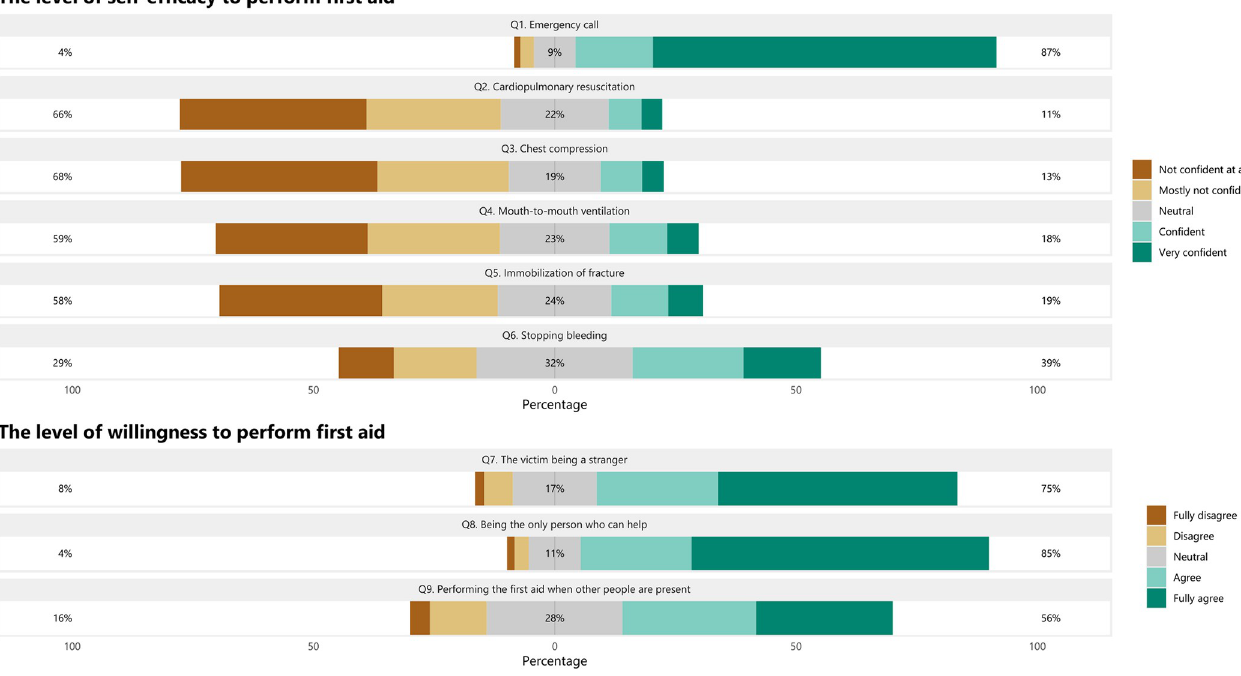
Fig 2. The self-efficacy and willingness of students regarding first